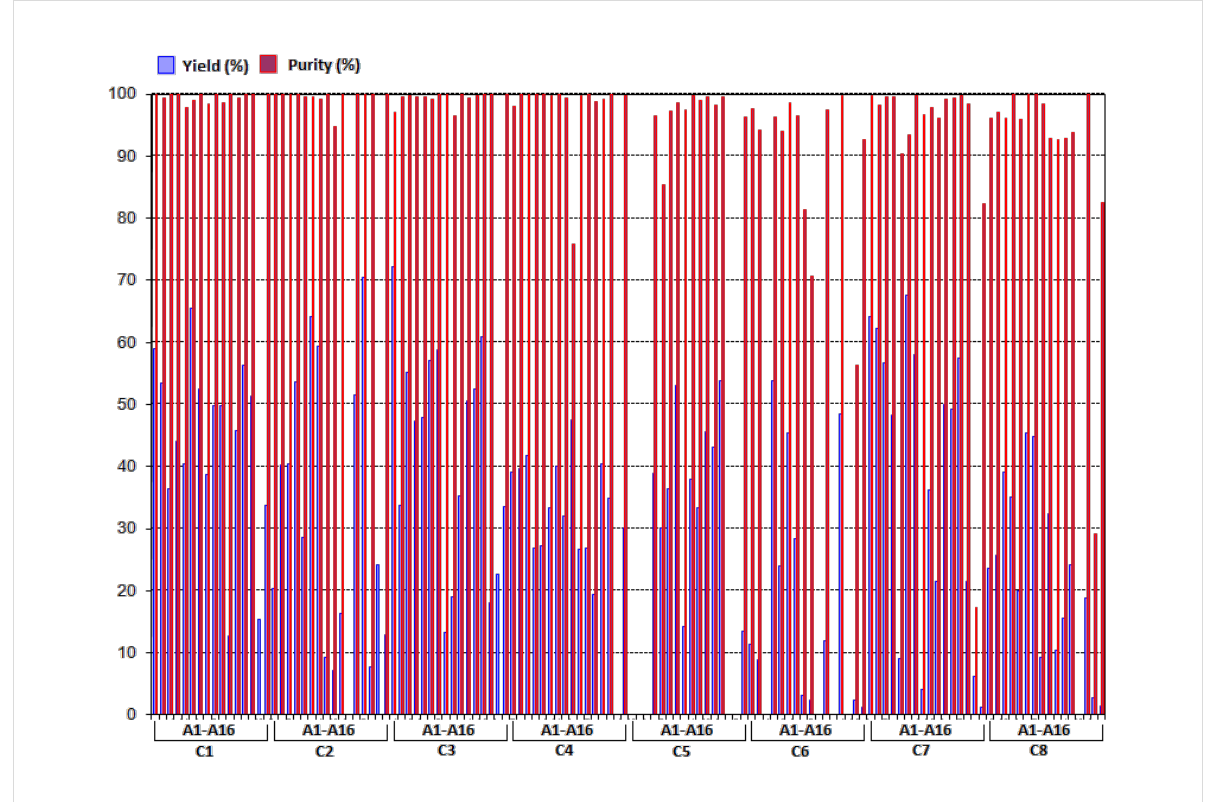
Figure 3: Results for the synthesis of a 128-member library of aminated coumarins by using the Chemspeed SLT100 automated synthesizer. Puri- fied by an automated preparative reverse-phase HPLC (Waters 2767 Mass Directed Fractionation) detected by UV (270 nm). Purity was determined by reverse-phase HPLC (Waters Alliance 2795 system) with peak area (UV) at 214